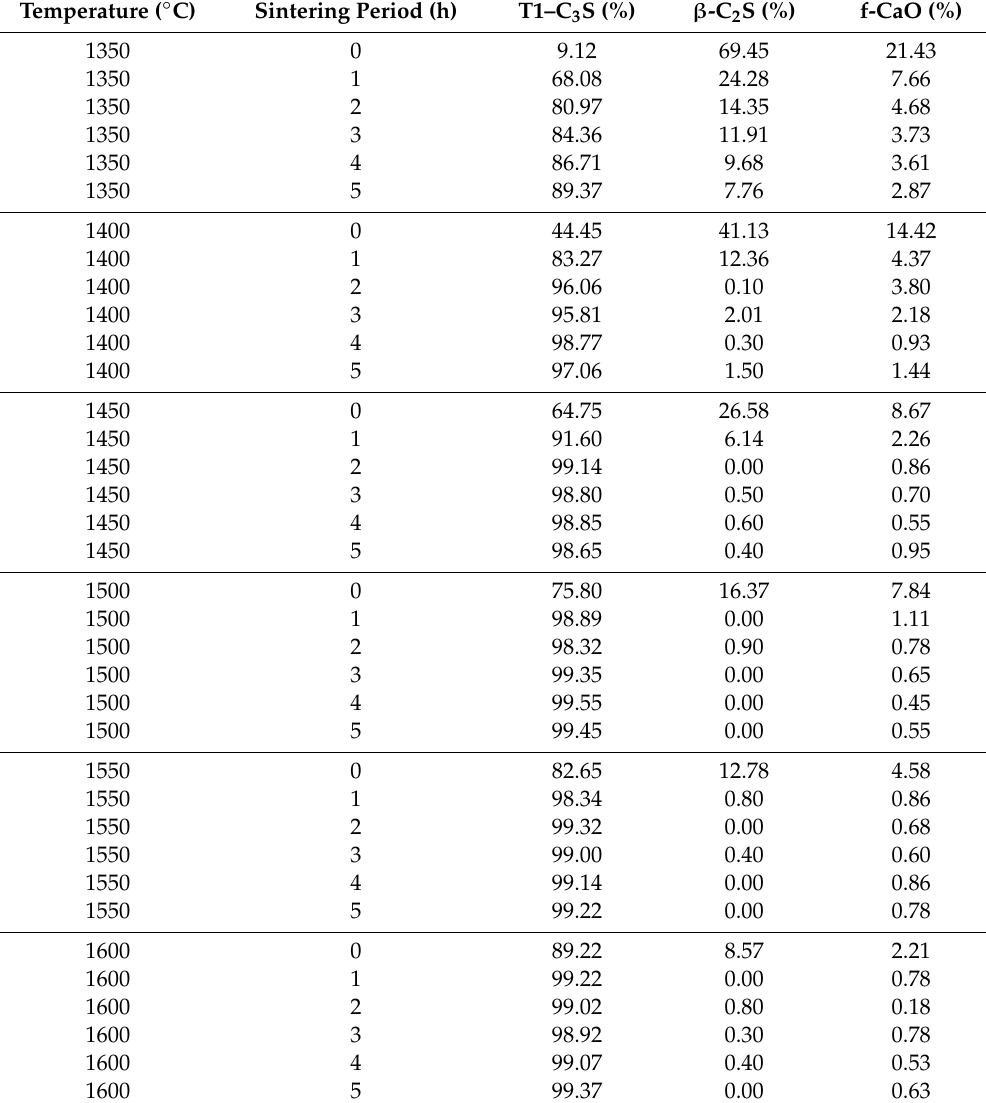
Table 2. Summary of mineral composition detected using Rietveld